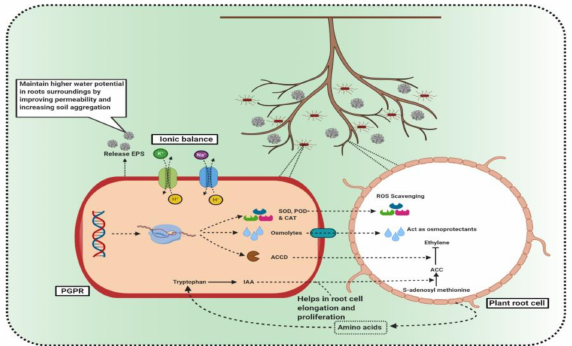
Figure 2. PGPR-mediated salt tolerance by multiple rhizospheric interactions in soil. (1) Release of plant growth regulators to improve nutrition uptake. (2) Production of antioxidant